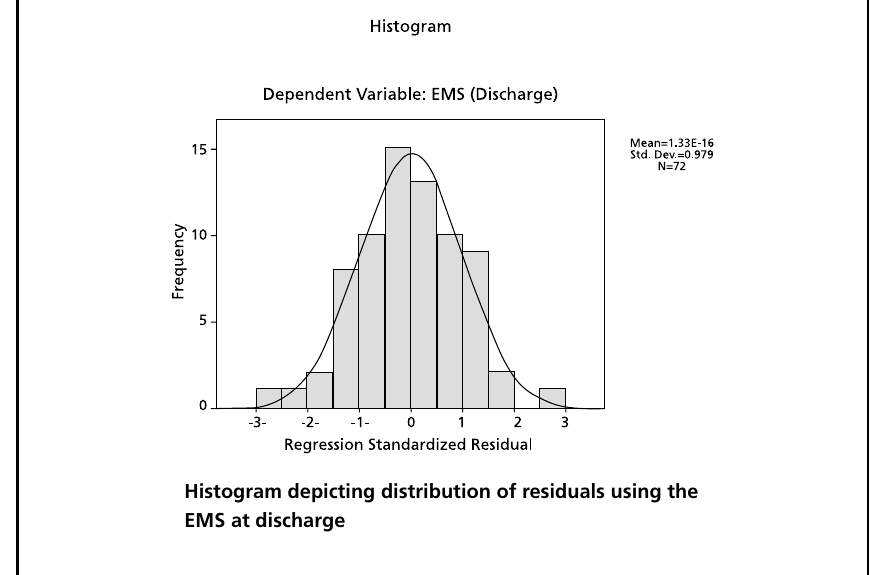
Figure 2: histogram depicting the distribution of variables using the elderly Mobility scale at discharge.